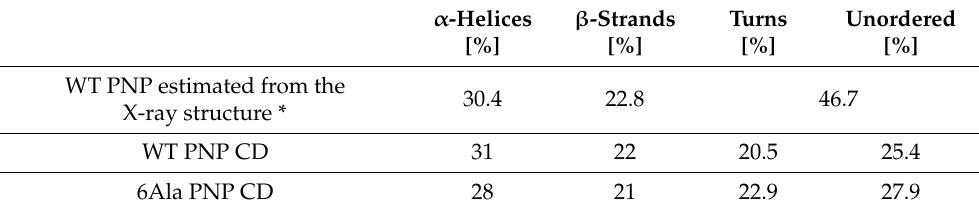
Table 2. Secondary structure elements in the mutant 6Ala PNP and WT PNP, according to the analysis of their CD spectra in DichroWeb.